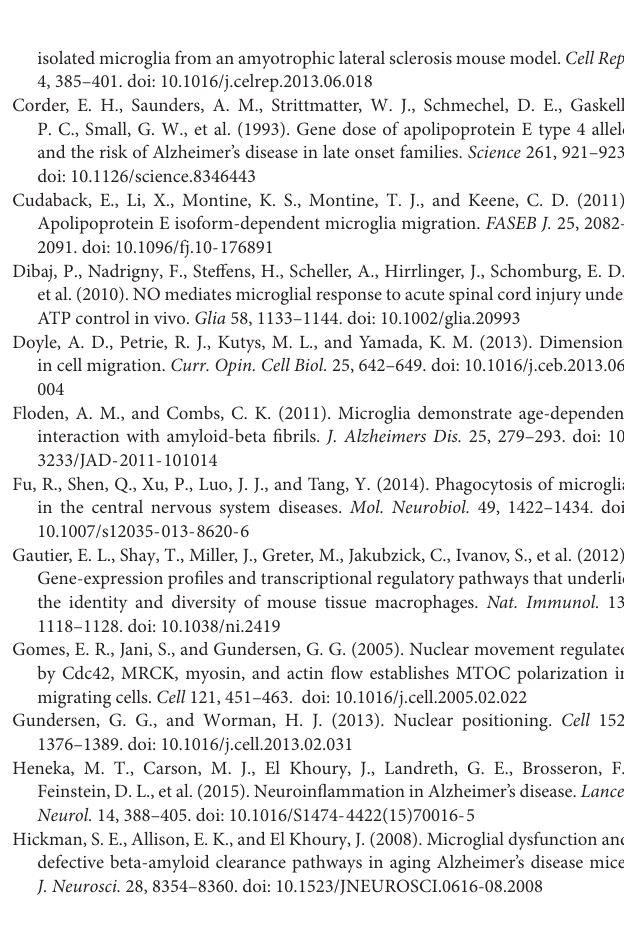
FIGURE S3 | ROCK1 expression is dysregulated in N9.ApoE4. (A) Western Blot analysis of ROCK1. PDI displays protein loading. (B) Quantification shows a significant downregulation of ROCK1 in N9.ApoE4 in comparison to N9.Wt ( n = 9). (C) Quantification of RNA-expression level of Rock1 shows a significant decrease in N9.ApoE4 in comparison to N9.Wt ( n = 7). Murine GapDH were used as endogenous control. TABLE S1 | Pairwise analysis of gene expression levels between untreated N9.ApoE3, and LPS treated N9.ApoE3 cells. TABLE S2 | Two-way ANOVA analysis of gene expression levels between untreated N9.ApoE3, LPS treated N9.ApoE3, and LPS treated N9.ApoE4 cells. TABLE S3 | Pairwise analysis of gene expression levels between LPS treated N9.ApoE3, and N9.ApoE4